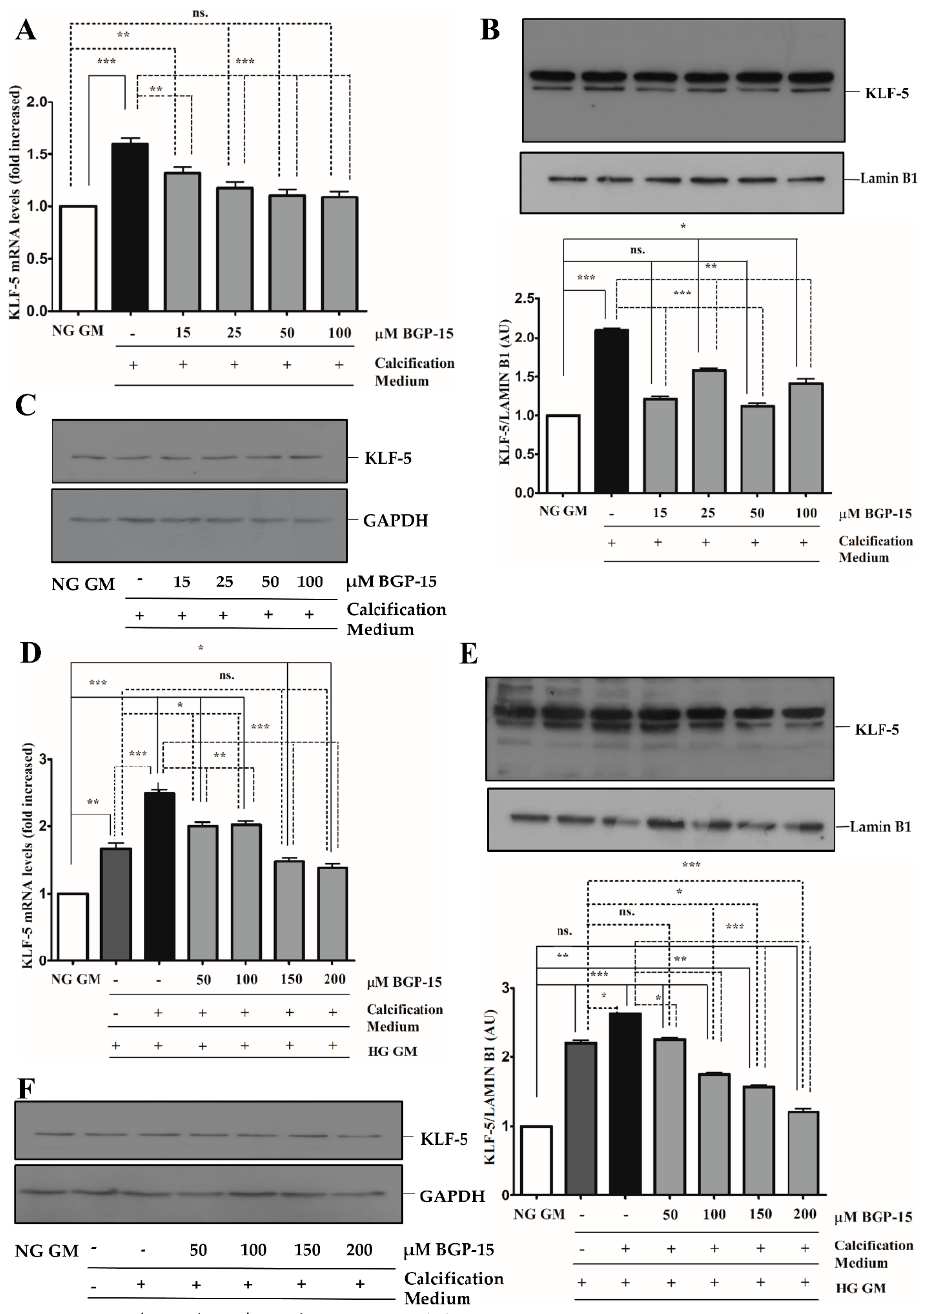
Figure 5. BGP-15 decreases KLF-5 expression and nuclear translocation induced by high Pi in NG and HG conditions. VSMCs were treated as in Figure 2. Expression of KLF-5 was analyzed by RT-qPCR and immunoblot ( A – F ). Relative expression of KLF-5 mRNA ( A ) and protein ( B , C ) in NG condition (( B ): Protein from nuclear extracts normalized to Lamin B1; ( C ): Cytosolic fractions normalized to GAPDH). Relative expression of KLF-5 mRNA ( D ) and protein ( E , F ) in HG condition (( E ): Protein from nuclear extracts normalized to Lamin B1; ( F ): Cytosolic fractions normalized to GAPDH). Data are presented as mean ± SEM of three independent experiments. Relative mRNA expression was normalized to RNA45S5. Statistical analysis was performed by the one-way ANOVA test followed by Bonferroni correction. A value of p < 0.05 was considered significant. * p < 0.05, ** p < 0.01, *** p <